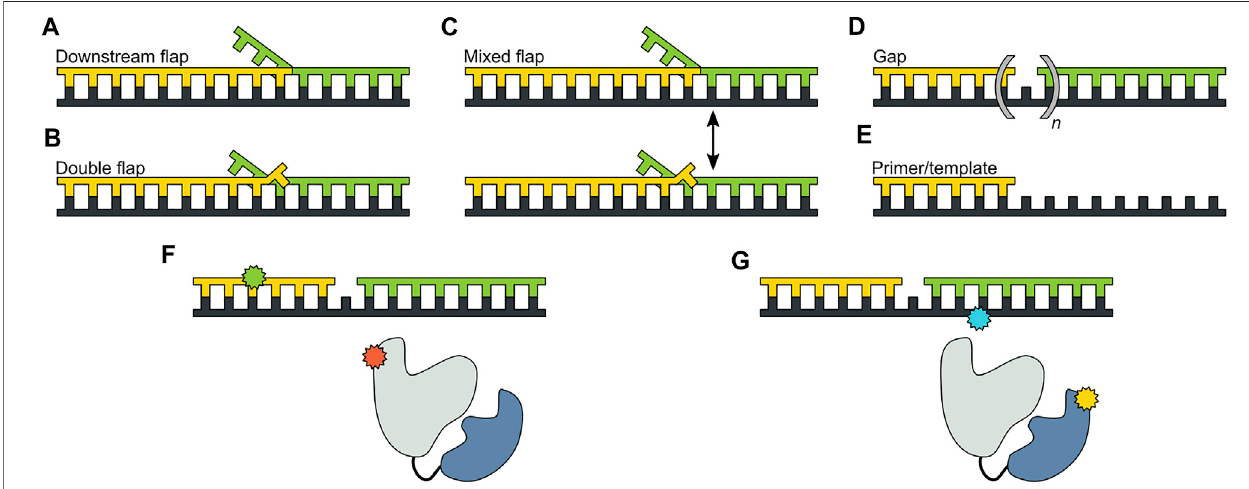
FIGURE8| DNAsubstratesandFRETlabelingstrategies. (A) Substratecontaininga5 ′ fl aponthedownstreamstrand. (B) Substratecontaining fl apsontheprimer anddownstreamstrands(double- fl ap). (C) Substratethatexistsasamixtureofdownstream fl apanddouble- fl apforms. (D) Substratescontaininggapsofvarioussizes. (E) Primer/template substrate, lacking a downstream strand entirely. (F) First FRET labeling scheme. Donor is green and acceptor is red. (G) Second FRET labeling scheme. Donor is yellow and acceptor is blue. Reproduced from reference (Pauszek et al., 2021) with